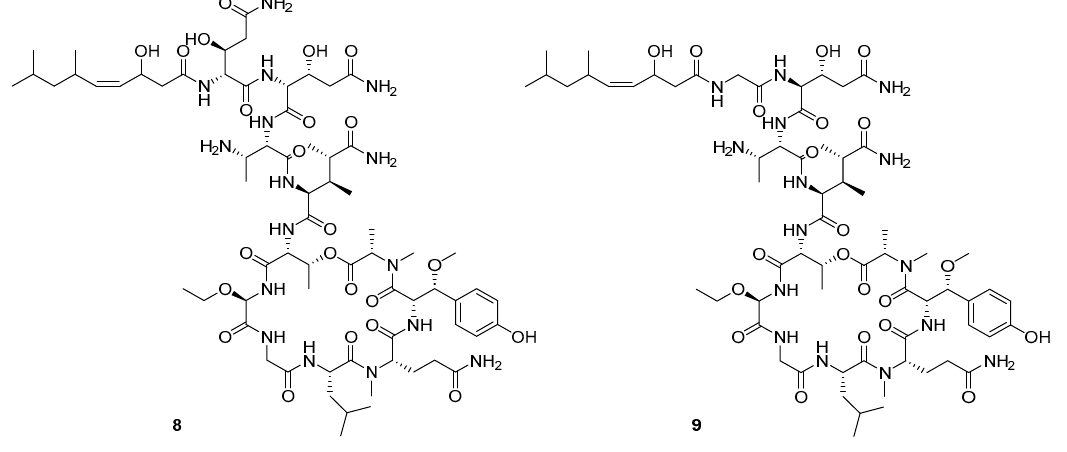
Figure 6. Structures of stelletapeptin ( 8 ) A and stelletapeptin B ( 9 ).